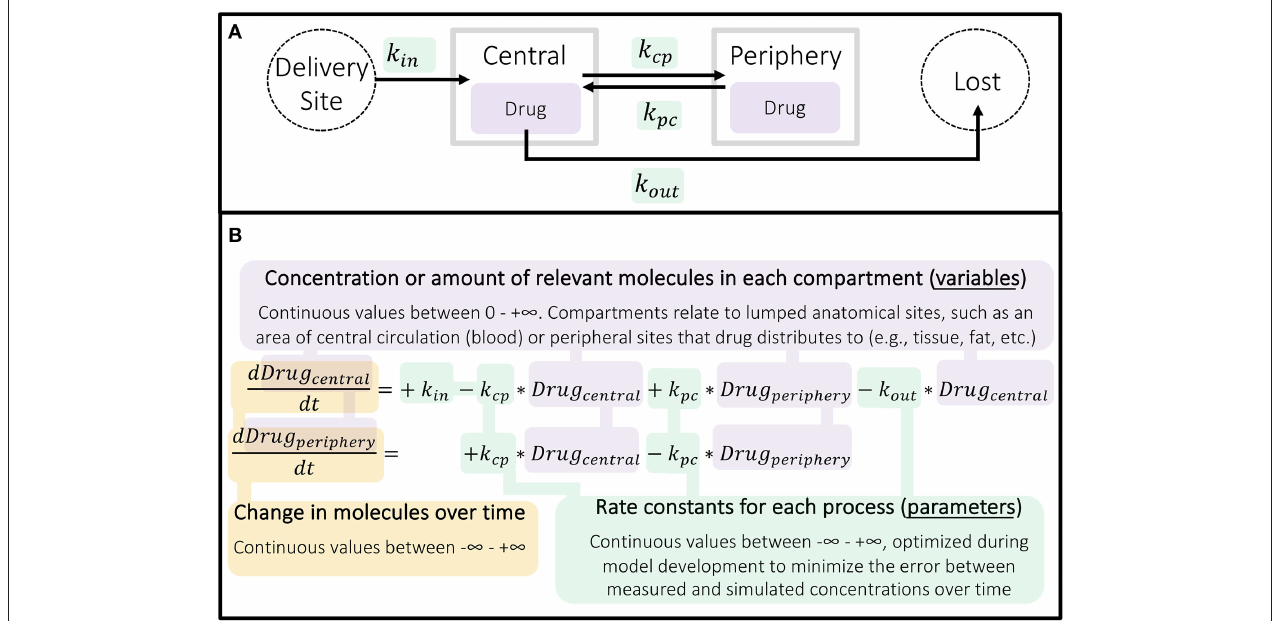
FIGURE 4 | Structure of basic two-compartment pharmacokinetic model. (A) Schematic of continuous processes represented in a two-compartment model. (B) The two ordinary differential equations (ODEs) used here describe the rate of change in concentration of the drug in the central and peripheral compartments over time as a result of these processes occurring. PK models can be more or less complex, with different compartments and processes included as needed to fully describe the drug being investigated in the simplest reasonable form.